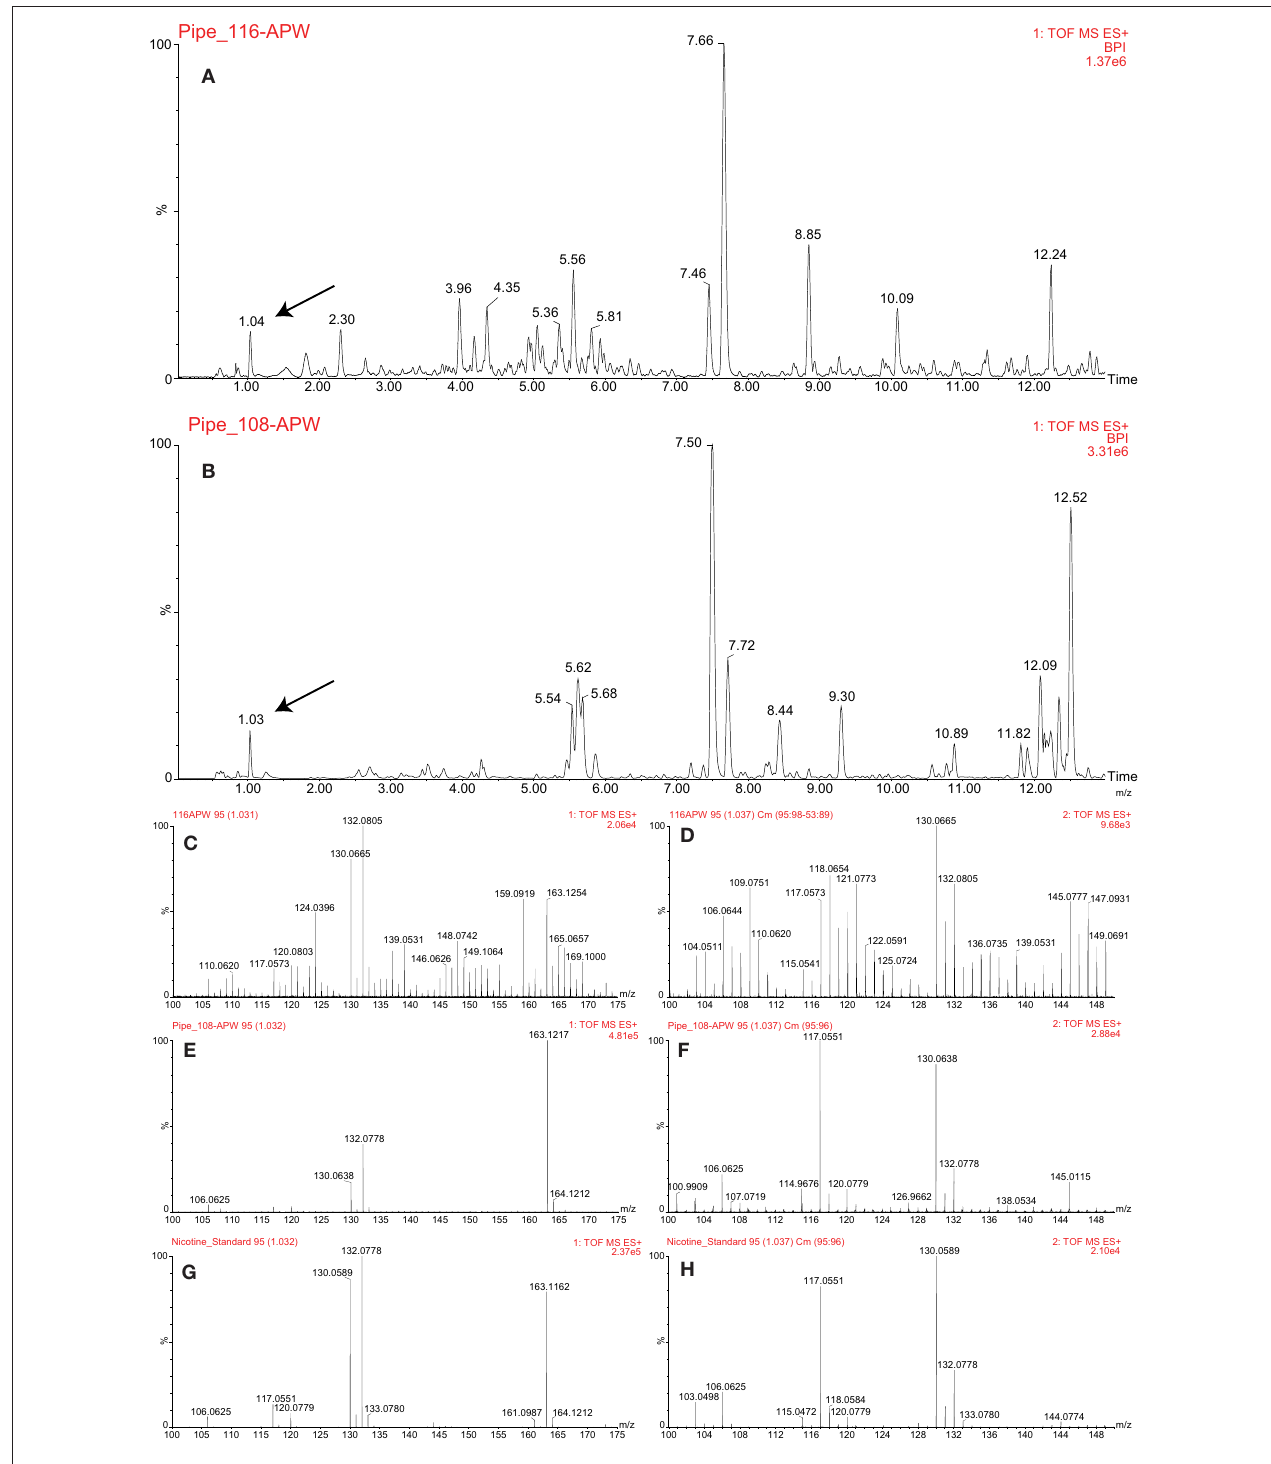
FIGURE 7 | LC-MS analysis of the pre-contact (PIPE_116) and post-contact (PIPE_108) pipes. Base peak intensity (BPI) chromatograms of acetonitrile:2-propanol:water [3:2:2] (APW) extracts from the pre-contact (A) and post-contact (B) pipes. The black arrows indicate the nicotine peak. MS (C,G) and MS E (D,H) spectra comparing the nicotine standard (G,H) to the peak identified as nicotine in the pre-contact pipe (C,D) . MS (E,G) and MS E (F,H) spectra comparing the nicotine standard (G,H) to the peak identified as nicotine in the post-contact pipe (E,F) .